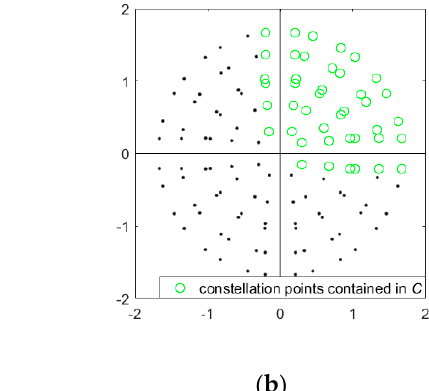
Figure 4. The subsets of ED comparison to calculate LLR( 𝑏 (cid:2871) ) when the received symbol is in the first quadrant. ( a ) Subsets of Max-Log-MAP algorithm; ( b ) Subsets obtained after some constellation points are removed.